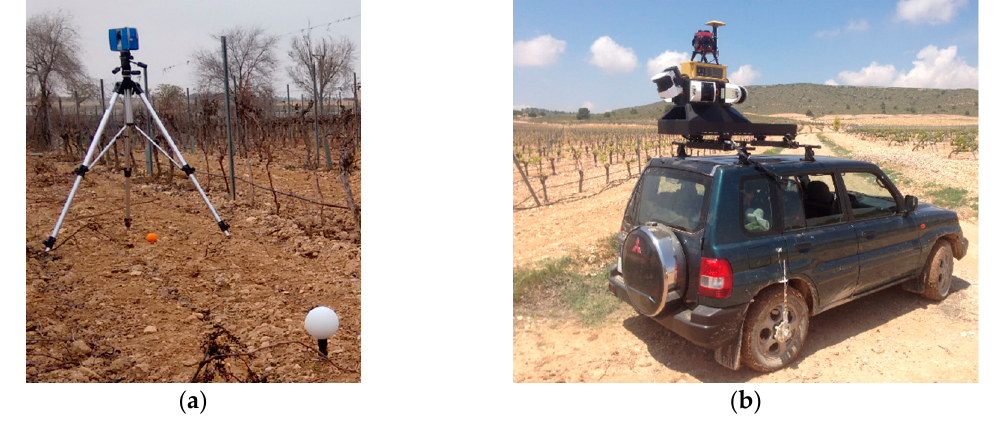
Figure 4. Laser scanner equipment. ( a ) A TLS mounted on a tripod with a head and calibrated sphere. ( b ) The MMS operating on a 4 × 4 vehicle.